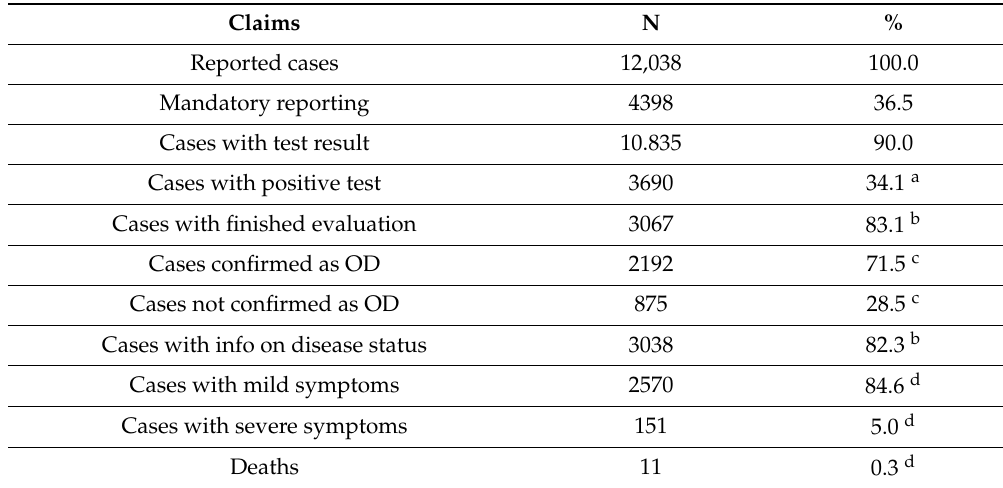
Table 2. COVID-19 cases reported to the BGW, test results, and progressions of illnesses.